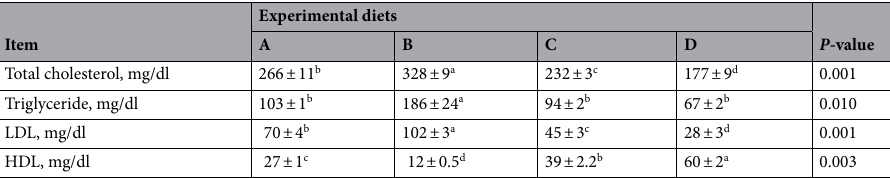
Table 5. Effect of DETOXIZYME supplementation on plasma lipids under clostridia infection in Cobb 500 broilers. a–c The means values placed at the rows by different superscript letters are significantly different (P < 0.05). Values are expressed as means ± standard error. Abbreviations: (A) control negative (basal diet), (B) control positive (basal diet supplemented with clostridia infection), (C) control positive group diet with 100 g DETOXIZYME/ton of feed, (D) control negative diet group with 100 g DETOXIZYME/ton of feed.